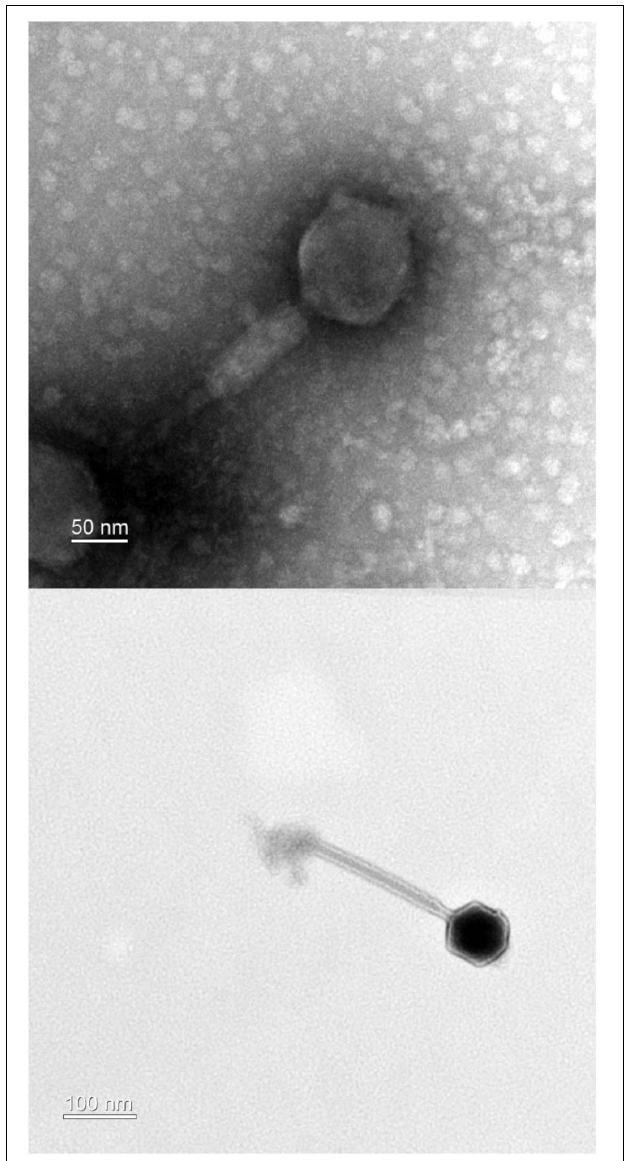
FIGURE 1 | Transmission electron microscopy of phage PALS2. The phage belongs to the family Myoviridae.